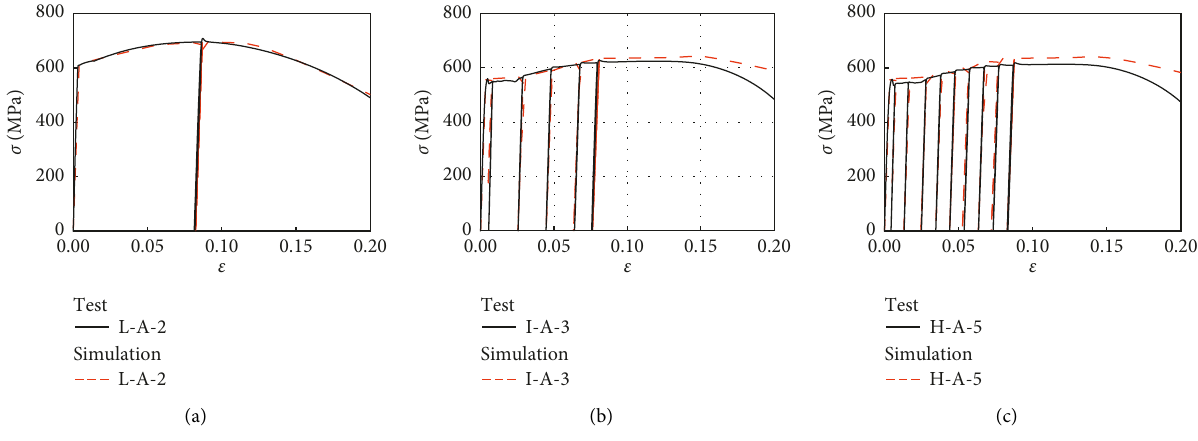
Figure 14: Comparison of stress-strain curves. (a) Specimen L-A-2. (b) Specimen H-A-3. (c) Specimen H-A-5. Table 6: Summary of dimensions of specimens in simulation